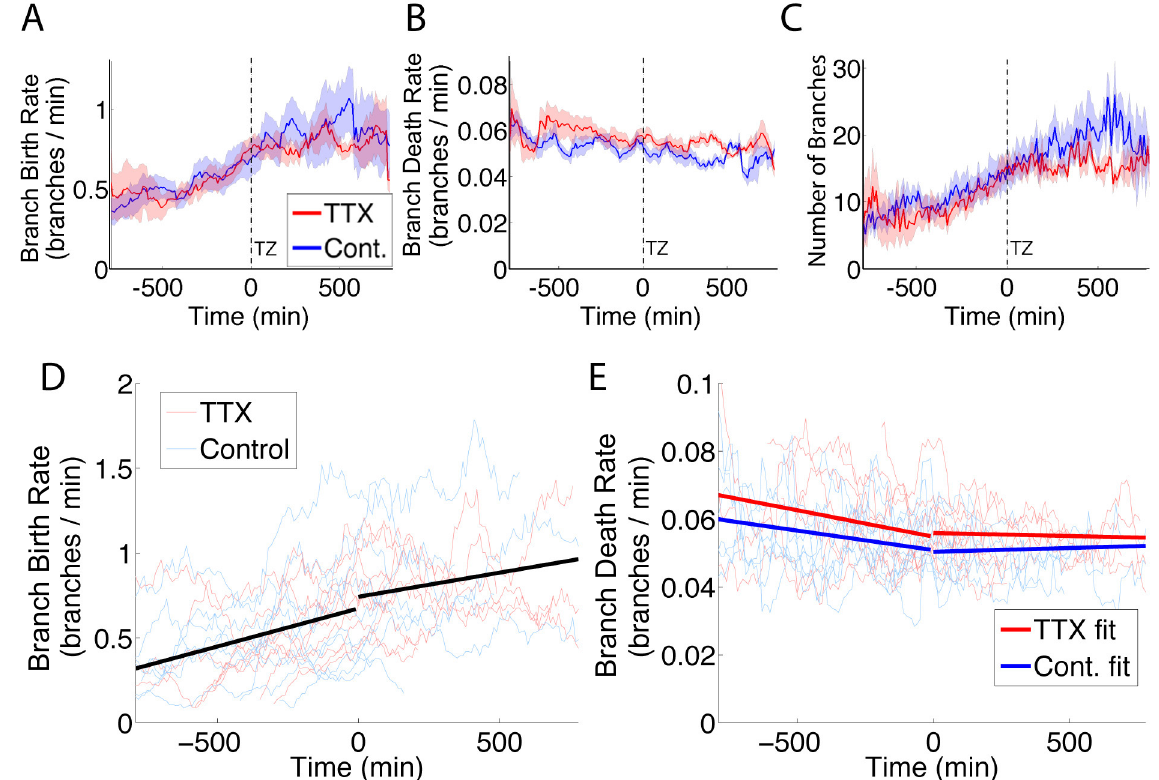
Fig 6. TTX treatment increased the death rate of branches but did not alter the birth rate. (A): The averaged ( ± SEM) branch birth rate for TTX-treated (red) and control (blue) axons increased until the TZ was reached and then plateaued. Times were aligned to the point the TZ was reached. (B): The averaged branch death rate ( ± SEM) was slightly higher for TTX-treated conditions (red) than for controls (blue), particularly after the TZ was reached. (C): The number of branches were averaged for each group over time ( ± SEM) and axons under control conditions had a higher number of branches than axons in TTX-treated environments after the TZ was reached. (D): The fitted model (including fixed effects only) of the birth rates (black). The slope and intercept of the birth rate changed after the TZ was reached. The individual axon results are shown for controls (blue lines) and axons in TTX-treated environments (red) in the background. (E): The fitted model for the average death rates of the TTX axons (bold red) was higher than that of controls (bold blue), shown over a background of the raw traces (thin lines). The fitted intercept for the TTX branches was higher than the control branches. See Table 1 for statistical tests relating to this